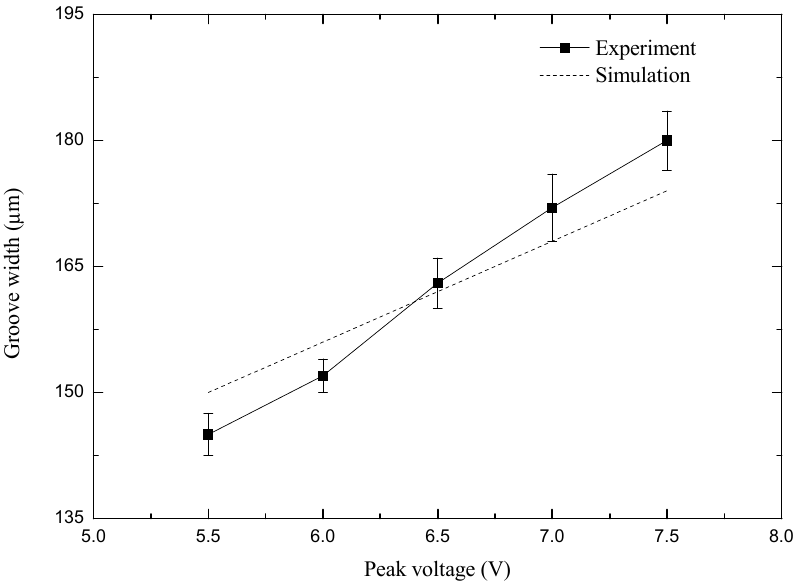
Figure 10. Curve of groove width with the peak voltage.